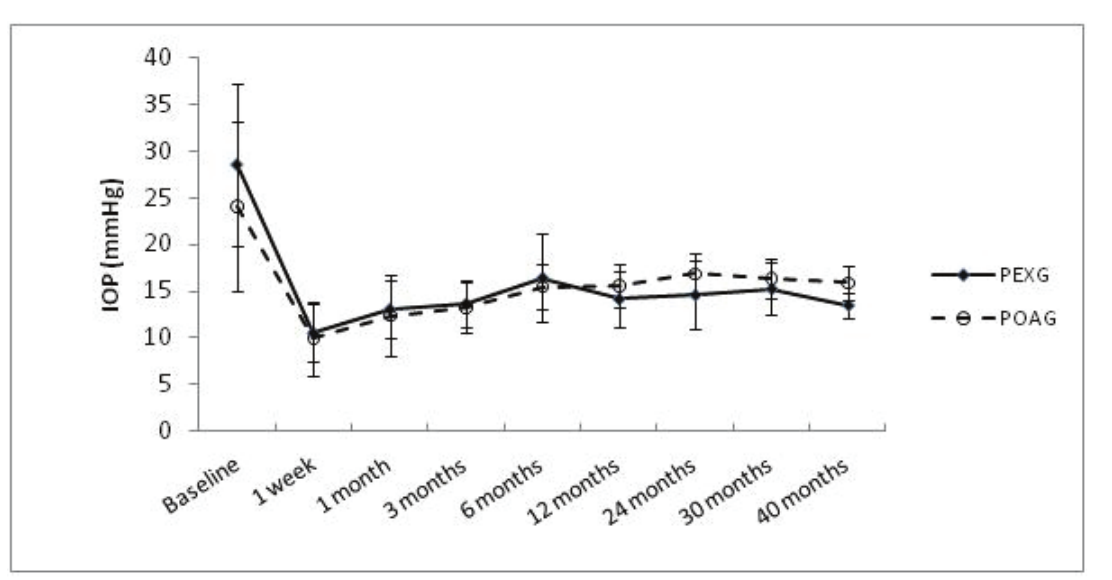
Figure 1. Mean intraocular pressure (IOP) over time in two groups. PEXG, pseudoexfoliation glaucoma; POAG, primary open angle